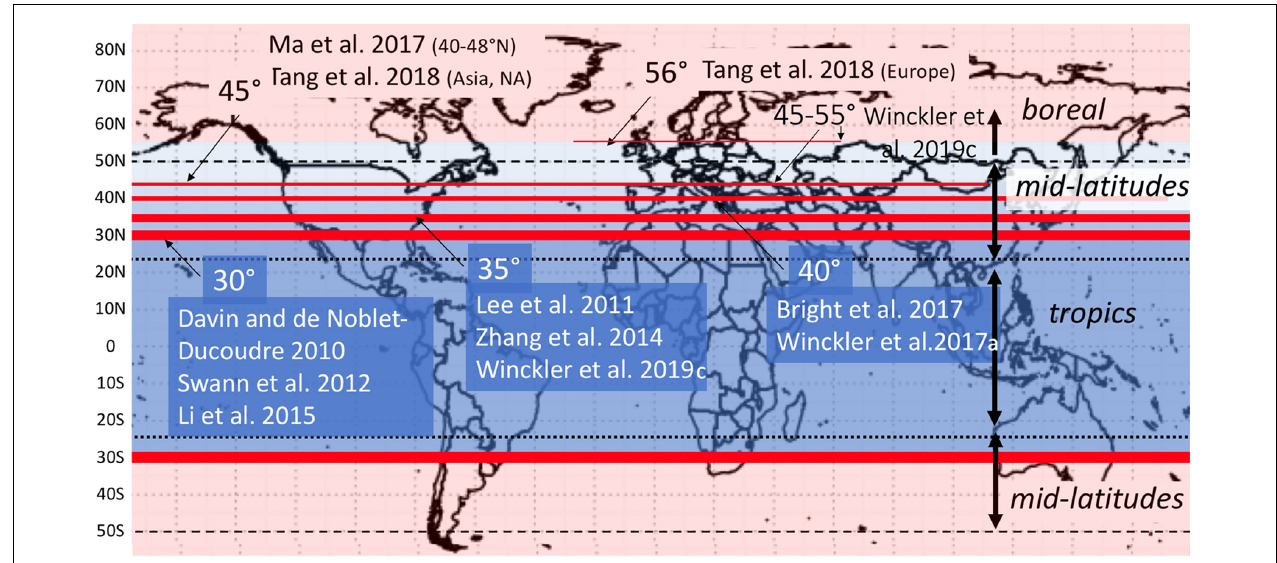
FIGURE 1 | Latitude of net zero biophysical effect of forests on local temperature varies from 30 to 56 ◦ N. Above the line, forest cover causes local warming; below the line, forest cover causes local cooling. The thickness of the line indicates the number of studies that show forest cooling up to that threshold. Data sources as